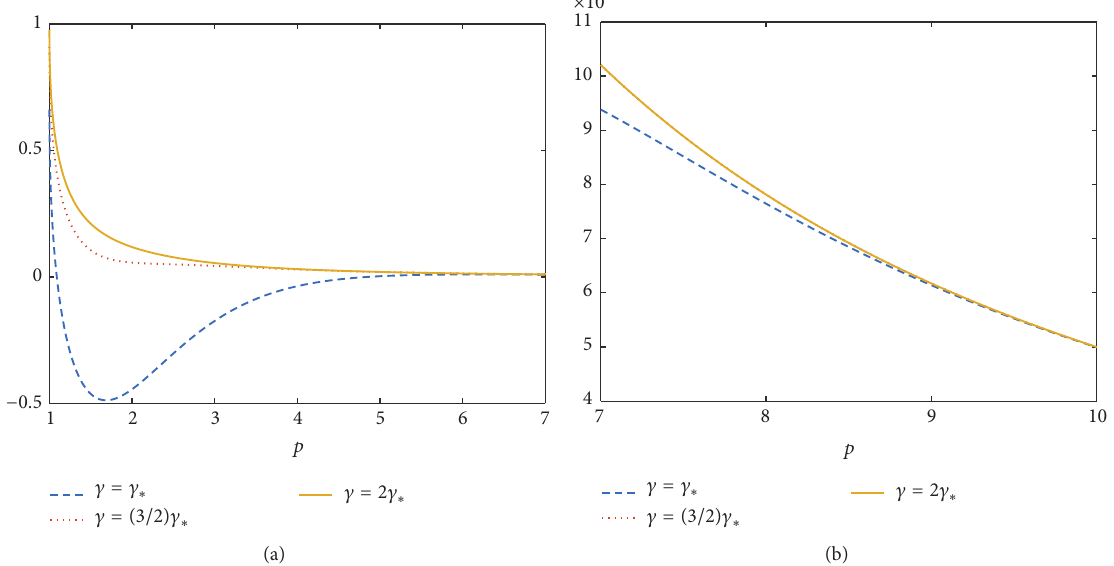
𝛾 = 2𝛾 ∗ . In particular, we have plotted the